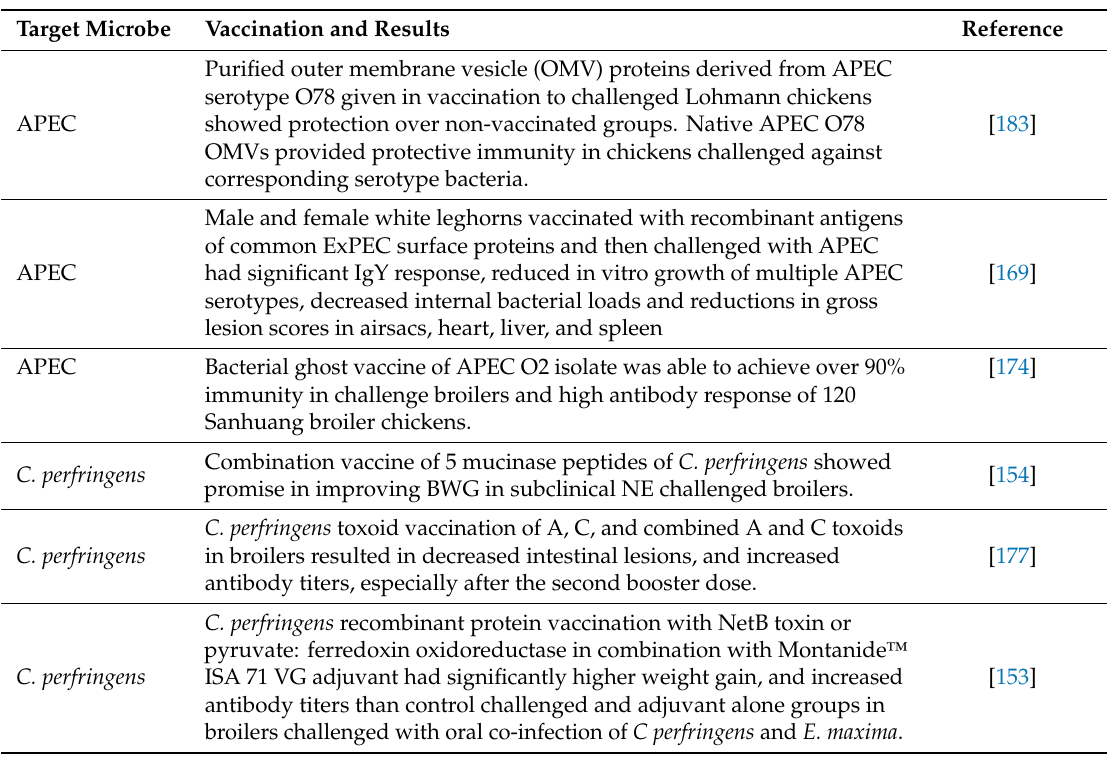
Table 1. Reports on the e ffi cacy of various vaccines against APEC and C. perfringens in broilers. Target